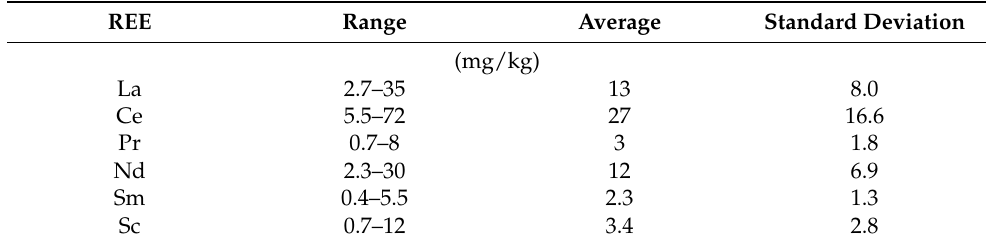
Table 1. Typical ranges, averages, and standard deviations of light REEs concentrations in soils in Poland [1]. REE Range Average Standard Deviation (mg/kg)